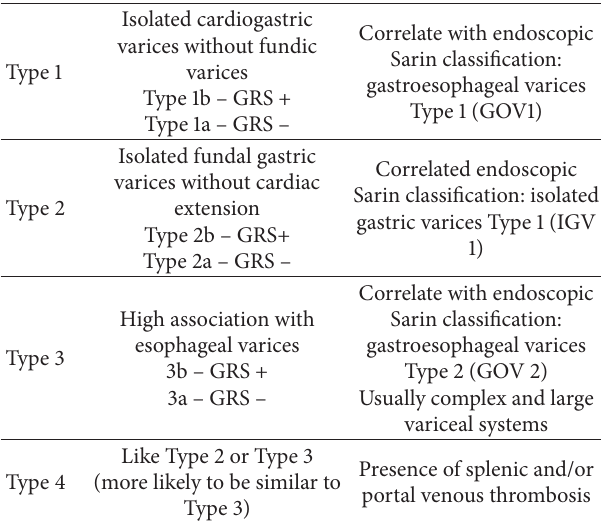
Table 2: The Saad-Caldwell Classification of gastroesophageal vari-